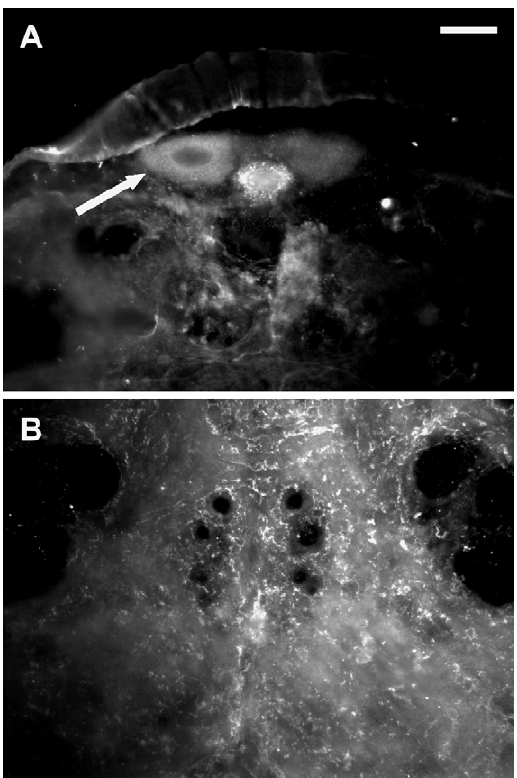
Figure 5. PSKR-like immunostaining in the nervous system . ( A ) Trans- versal slice of the posterior part of the sixth abdominal ganglion. The arrow indicates a DUM neuron showing pronounced immunostaining. Bar, 50 m m. ( B ) Transversal slice of the sixth abdominal ganglion displaying immunostain- ing within the neuropile